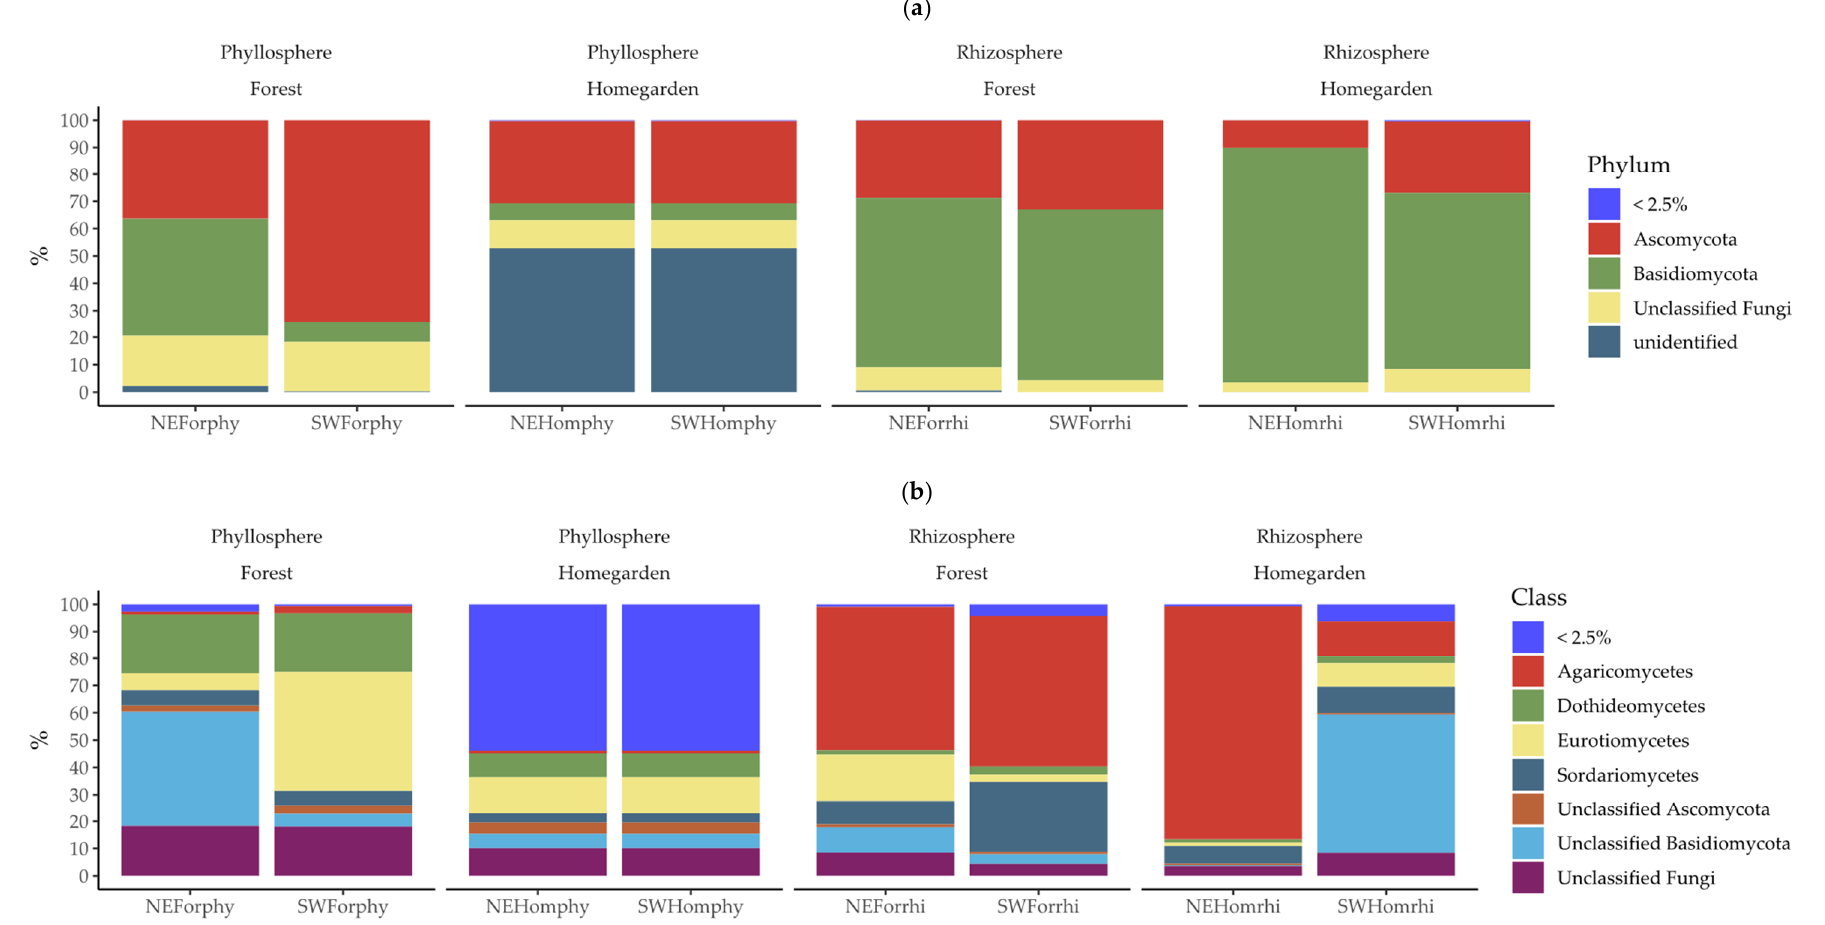
Figure 4. Relative frequency of ( a ) phylum and ( b ) class assigned to 1096 fungi OTUs from phyllosphere and rhizosphere microbiota in Yucatán´s forest and homegarden populations of Cordia dodecandra .